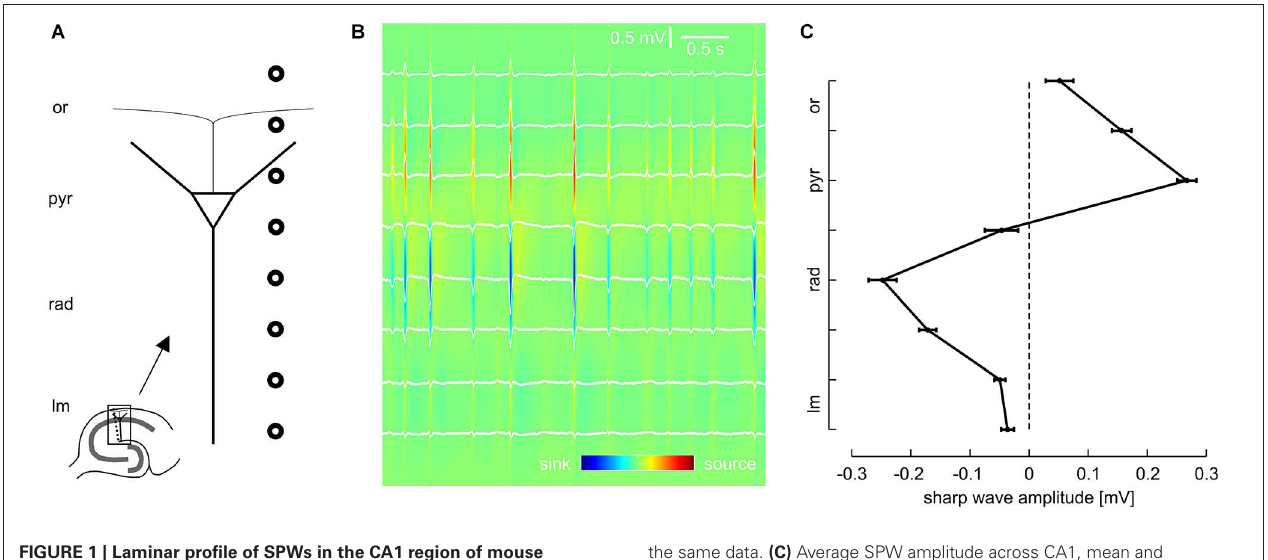
FIGURE 1 | Laminar profile of SPWs in the CA1 region of mouse hippocampal slices. (A) Schematic of recording electrode position. (B) Representative LFP recordings from eight sites, located as illustrated in (A) , and current source density (CSD) plot calculated from